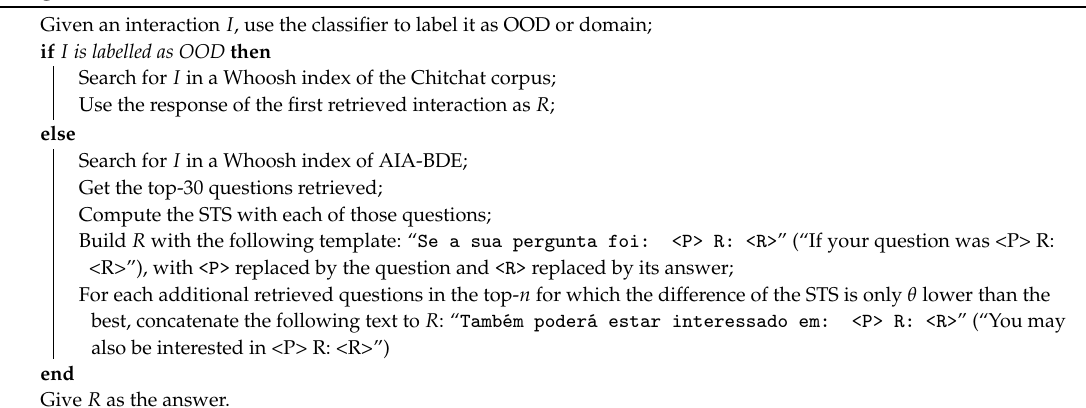
Algorithm 1: Amaia’s workflow.